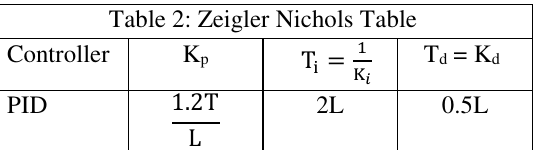
Table 2: Zeigler Nichols Table